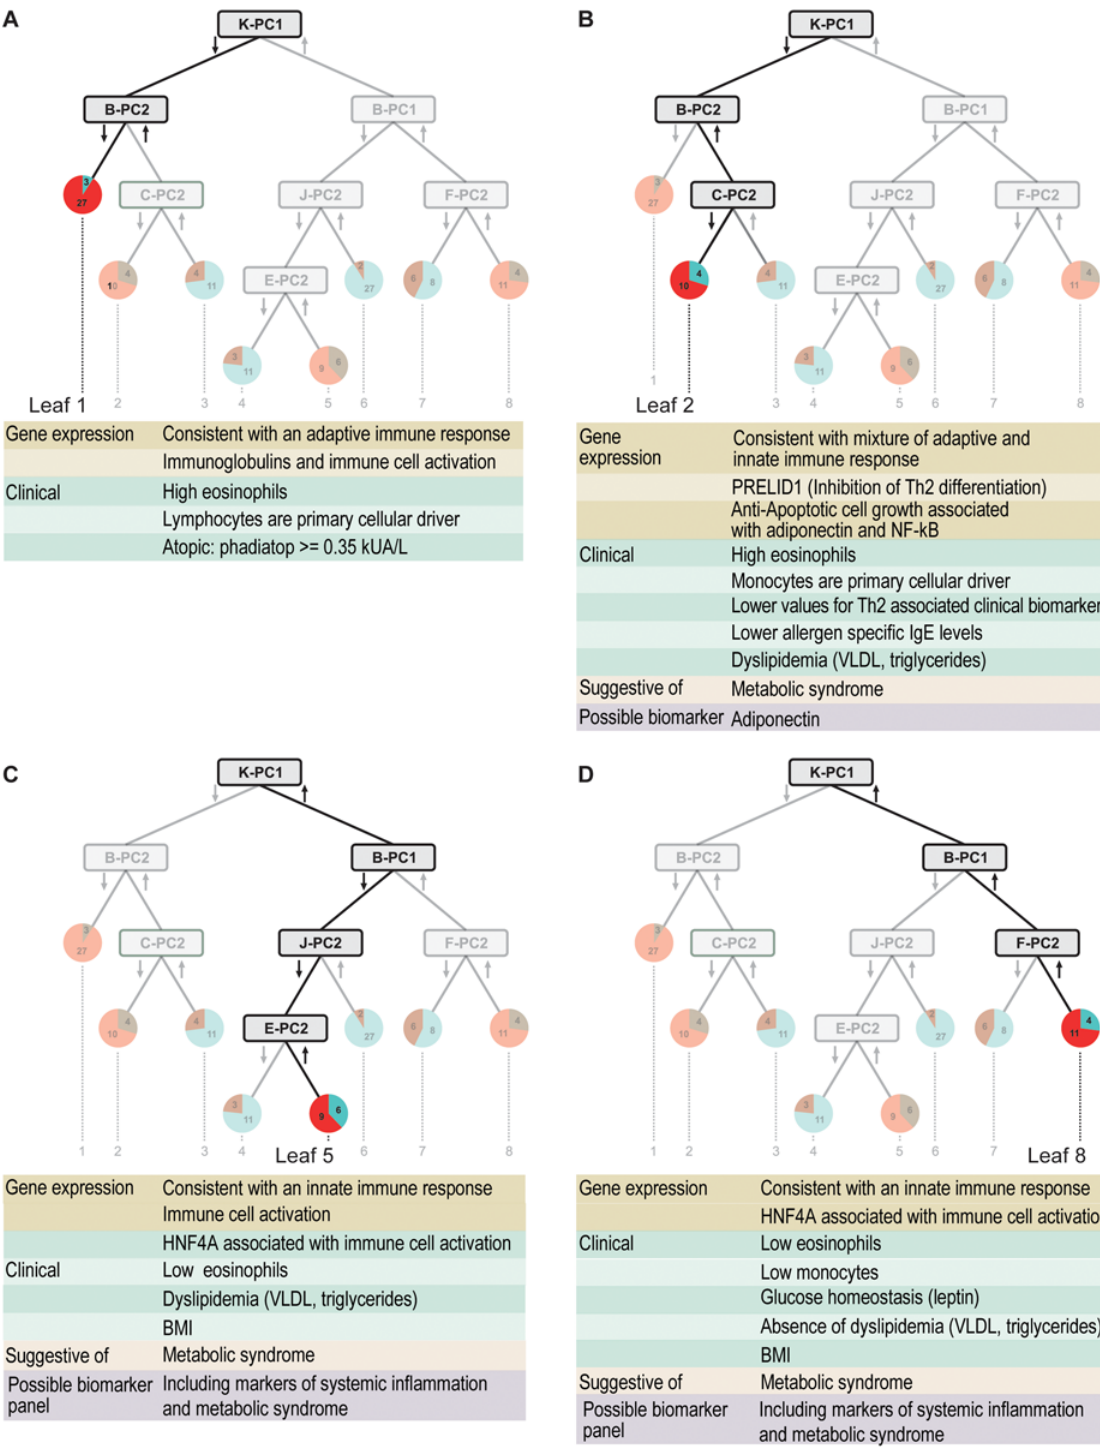
Fig 3. Four distinct asthma endotypes identified by data-driven integration of blood gene expression and clinical biomarkers. Underlying mechanistic information is suggestive of metabolic syndrome and potential biomarkers.